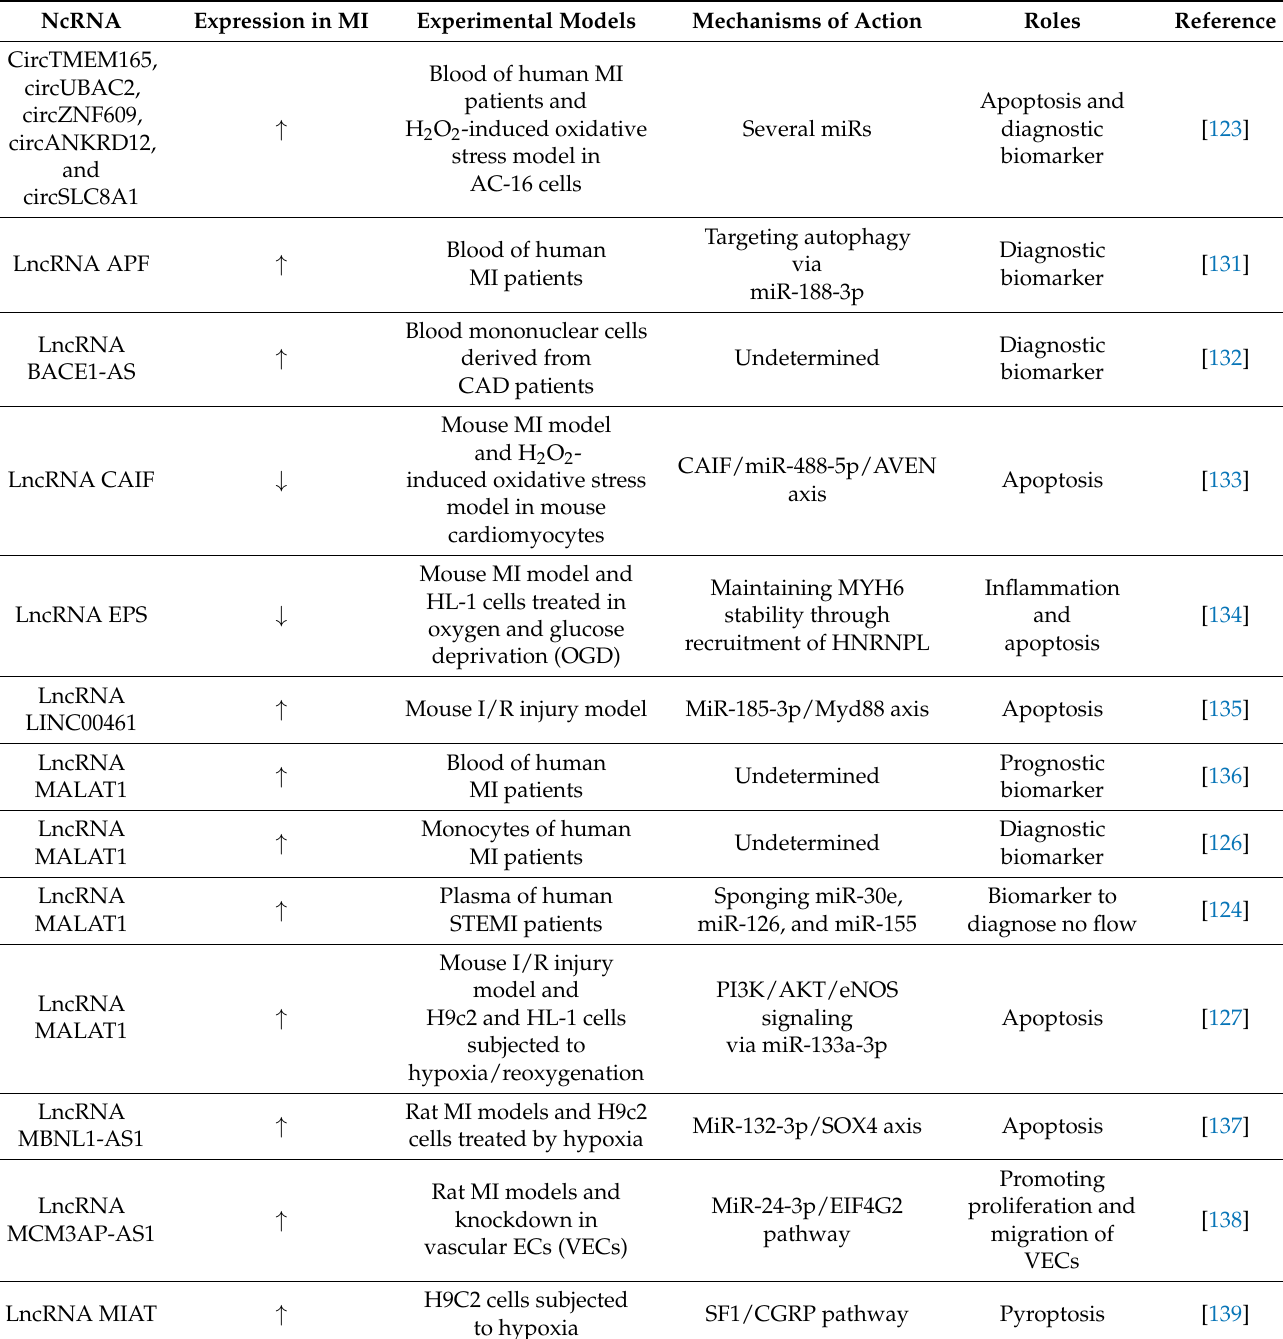
Table 3. Noncoding RNAs in myocardial infarction